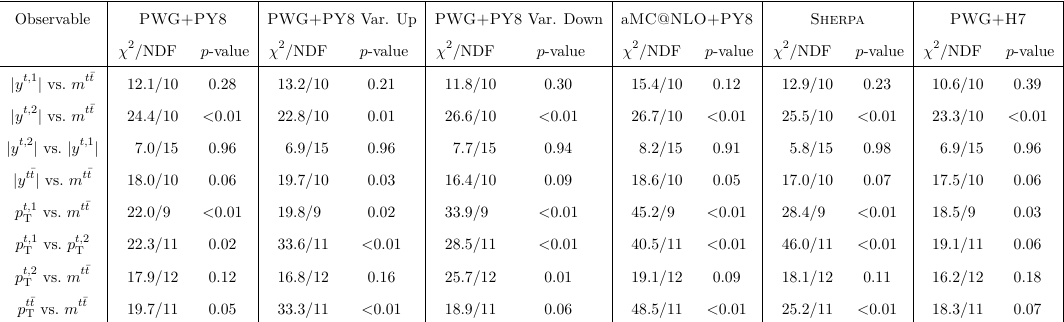
Table 15 . Comparison of the measured parton-level normalised double-differential cross-sections with the predictions from several MC generators. For each prediction, a χ 2 and a p -value are calculated using the covariance matrix of the measured spectrum. The number of degrees of freedom (NDF) is equal to the number of bins in the distribution minus